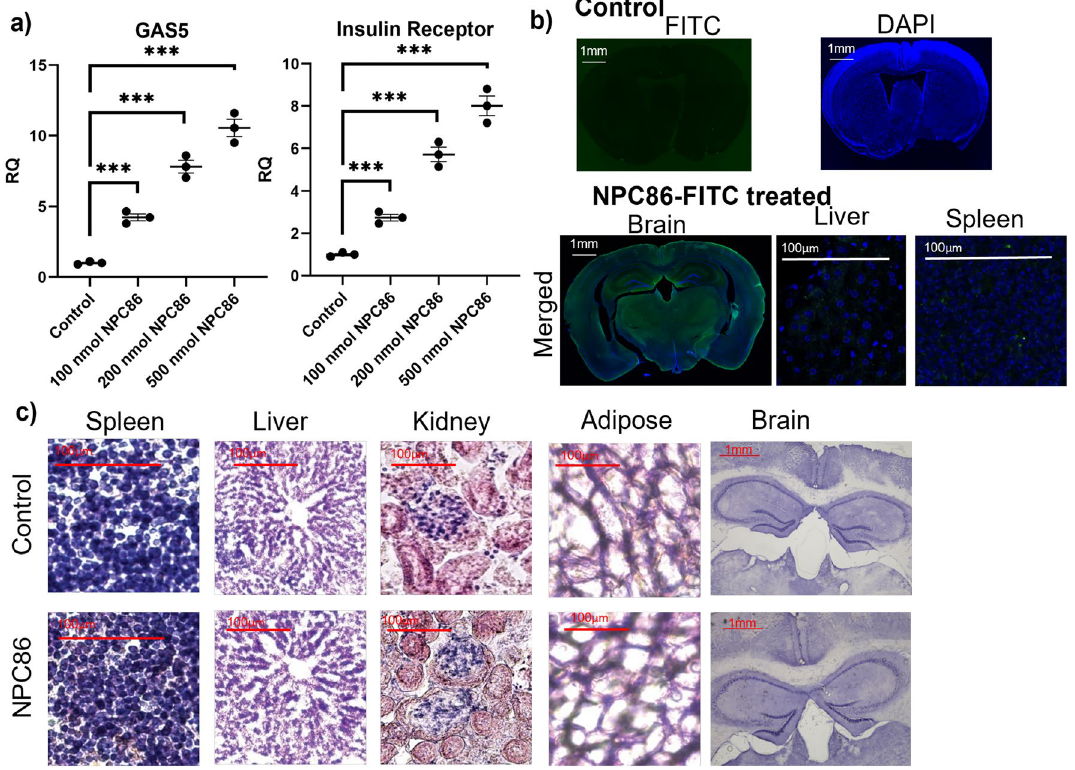
Figure 4. Efficacy and Safety of NPC86 in vivo in mice. ( a ) Increasing doses of NPC86 (100 nmol, 200 nmol or 500 nmol) or 100 nmol PBS vehicle (Control) was administered intranasally to young mice. RNA was isolated from hippocampus and qPCR performed using primers specific to GAS5 and insulin receptor and normalized to β-actin levels. Relative quantification (RQ) was determined using control as reference. Statistical analysis was performed by one-way ANOVA, ***p < 0.001. ( b ) All sections were treated with Sudan black B (SBB) dye to eliminate autofluorescence and nuclear counterstained with DAPI. Histochemistry of brain (scale bar 1 mm) from control mice and NPC86-FITC treated mice, liver (scale bar 100 μm), and spleen (scale bar 100 μm) from mice treated with NPC86-FITC (n = 5). c) Hematoxylin and eosin (H&E) staining of spleen, liver, kidney, adipose tissue (all with scale bar 100 μm) and brain (scale bar 1 mm) of control and 100 nmol NPC86-FITC treated mice (n =